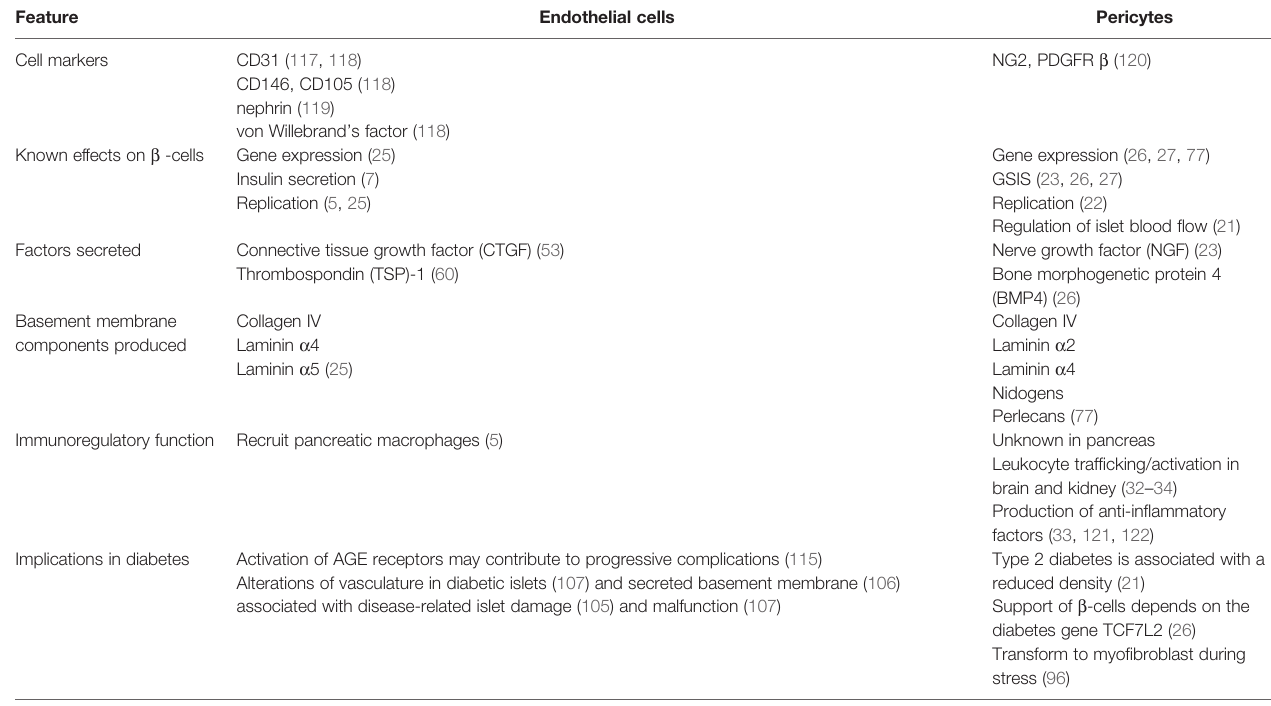
TABLE 1 | Islet Vascular Cell Features (Summary